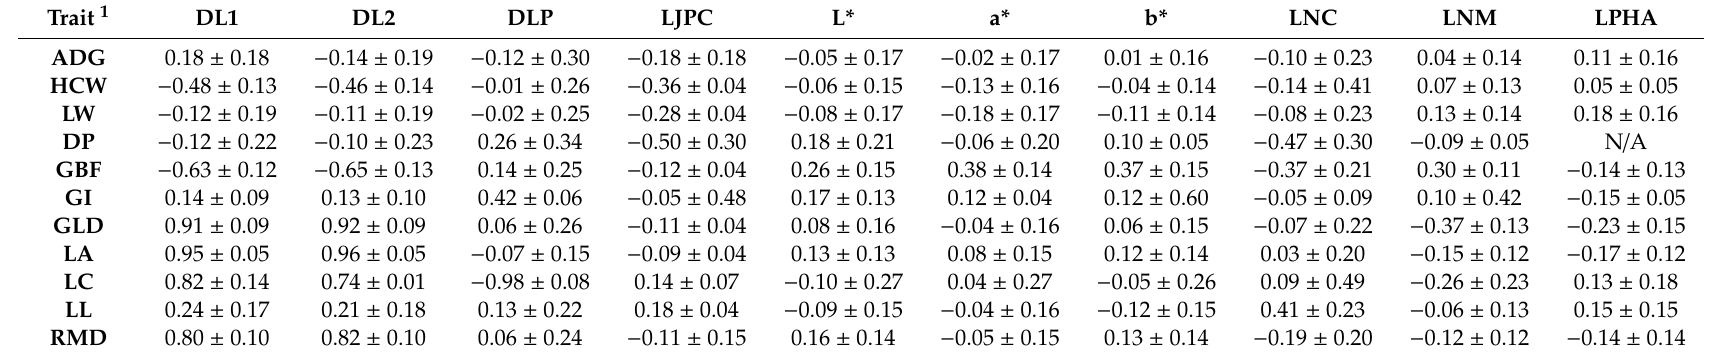
Table 8. Genetic correlations between conventionally measured carcass traits and pork quality